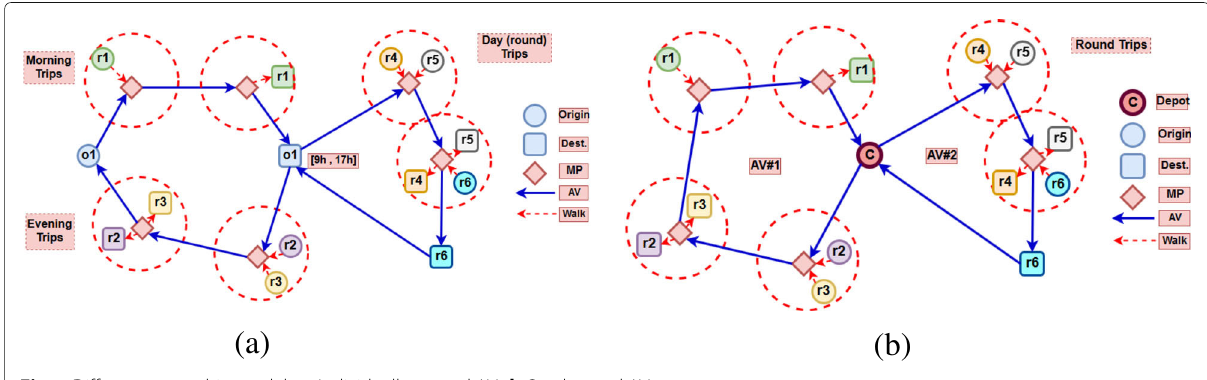
Fig. 1 Different ownership models. a Individually-owned AVs b On-demand